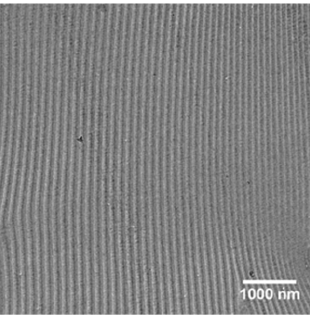
Figure 1. TEM image of the PS- b -P2VP sample with a thickness over 45 L 0 annealed in chloroform vapor atmosphere at 27 °C for a week. Table 2. Vapor pressure (VP), Hildebrand solubility parameter ( δ ), and enthalpy derived interaction parameter ( χ H ∞ ), relative to the individual blocks and the copolymer, for toluene and chloroform at 273.15